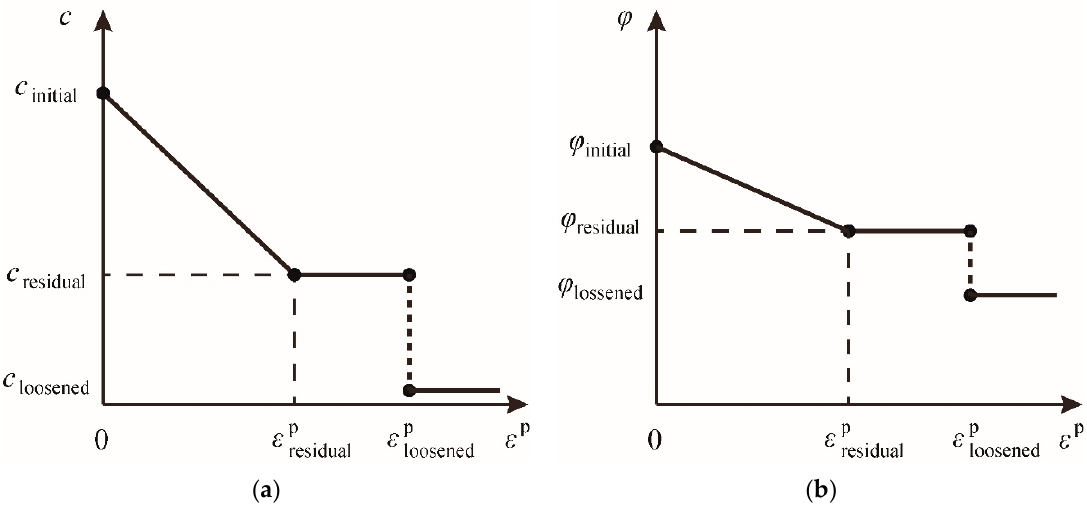
Figure 6. Softening model of strength parameters: ( a ) softening model of cohesion; ( b ) softening model of friction